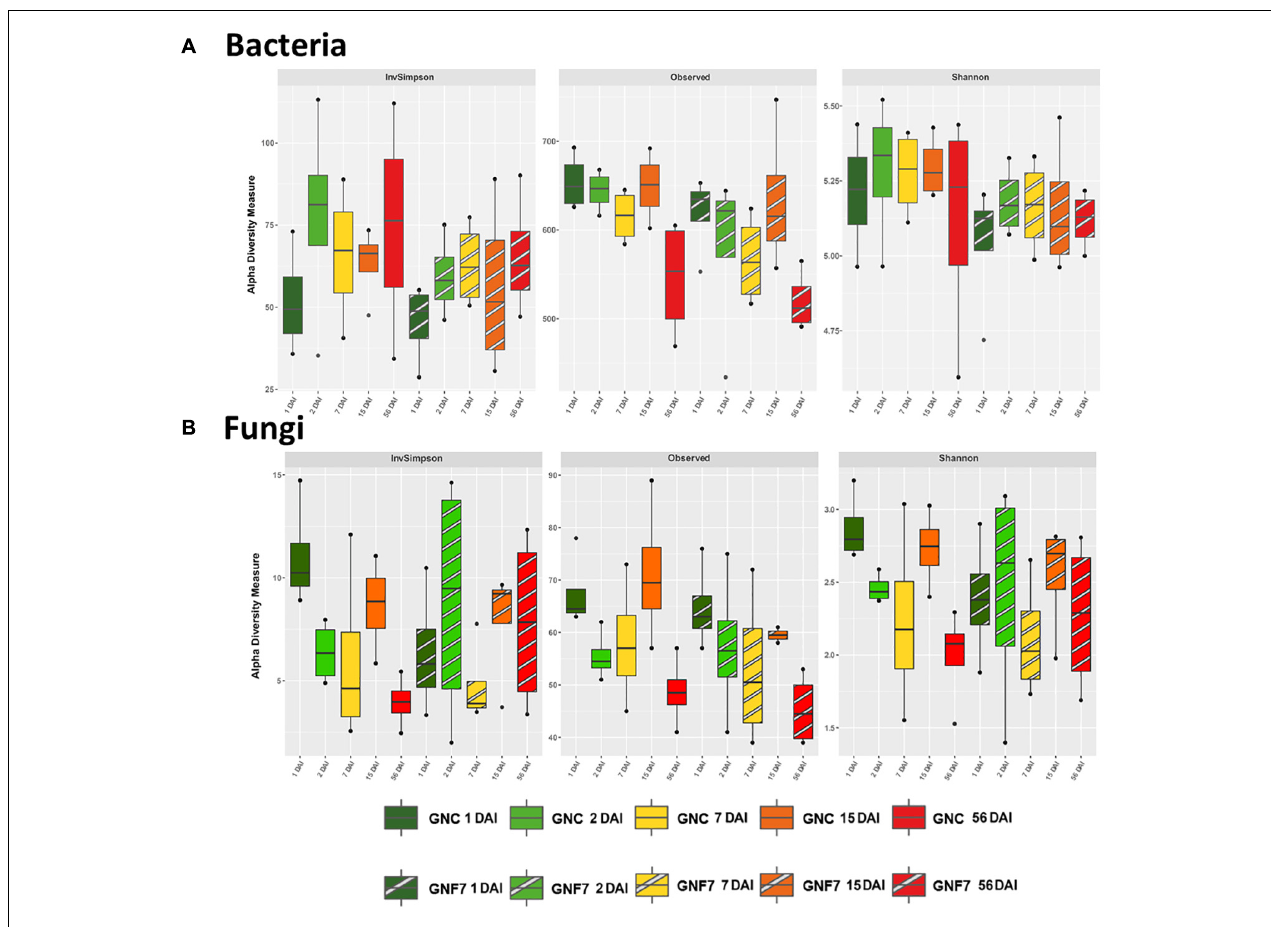
FIGURE 1 | Box plot of α -diversity indices: InvSimpson, observed amplicon sequence variants, and Shannon for the bacterial (A) and fungal (B) communities of control (GNC) and Pseudomonas simiae PICF7-inoculated (GNF7) plants at different time-points (days after inoculation,